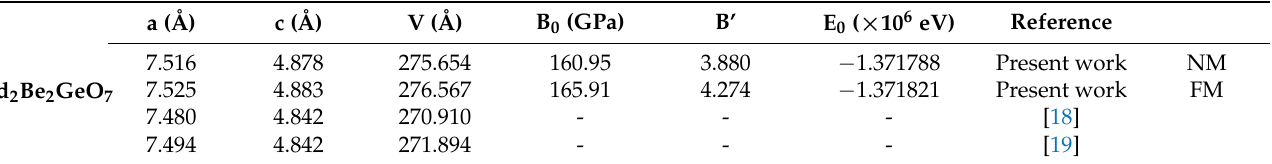
Figure 1. ( a ) The melilite crystalline structure of Gd 2 Be 2 GeO 7 compound, ( b ) connectivity of GdO 8 polyhedrons in the ab plane, and ( c ) c coordination environments of GdO 8 , BeO 4 , and GeO 4 polyhedron. Figure 1: (a) The melilite crystalline structure of Gd 2 Be 2 GeO 7 compound, (b) connectivity of GdO 8 polyhedrons in the ab plane, and (c) c coordination environments of Table 1. Lattice constants a and c, bulk modulus B 0 , and its pressure derivative B’ parameters opti- GdO 8 , BeO 4 , and GeO 4 polyhedron. mization in both ferromagnetic (FM) and nonmagnetic orders (NM). For comparison, experimental and other theoretical values are included